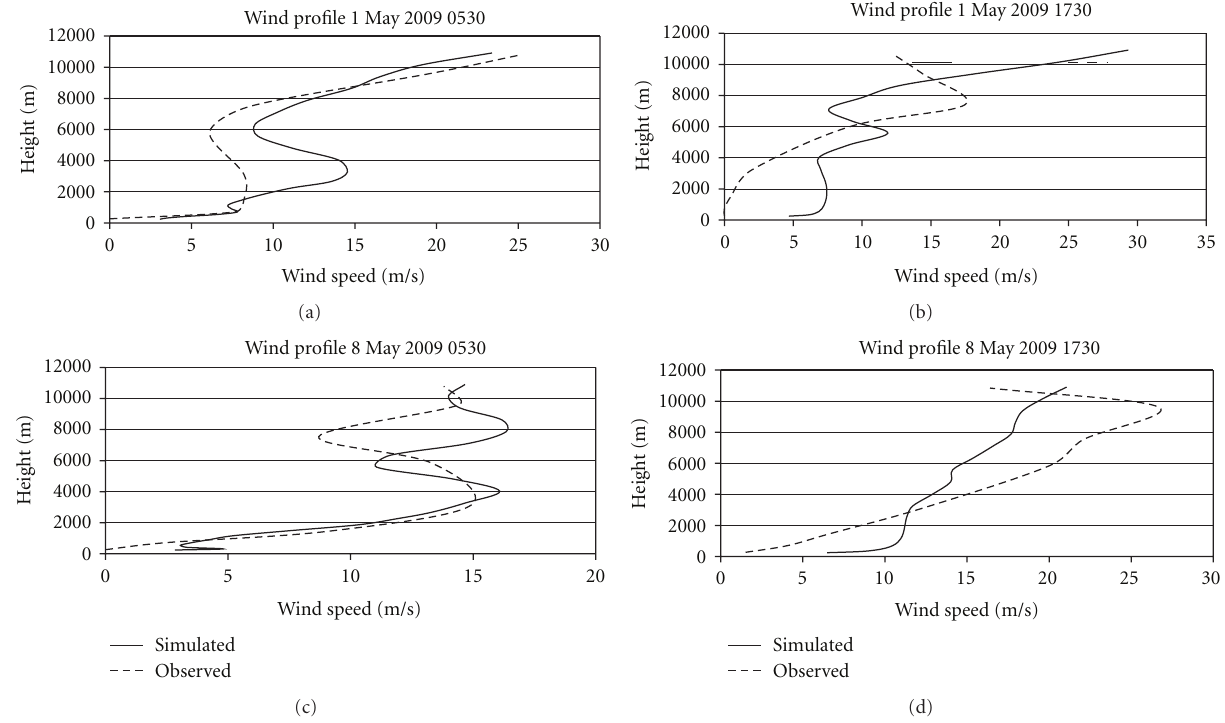
Figure 8: Wind profile of selected days: 1 May 2009 and 8 May 2009 at 0530 1730